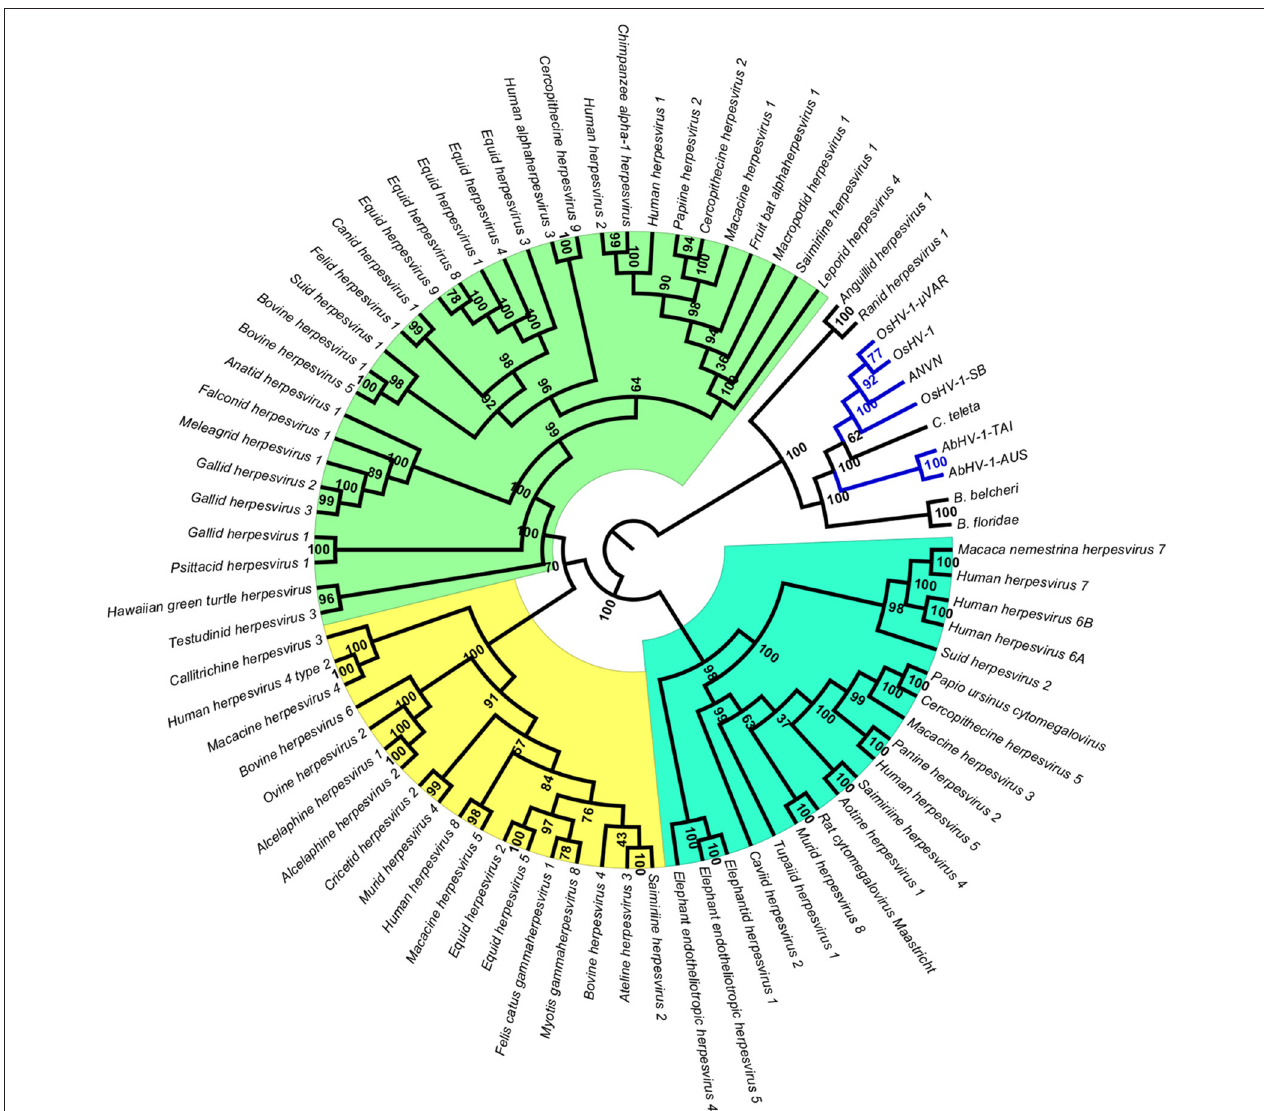
FIGURE 2 | Phylogenetic tree of catalytic subunit of DNA polymerase . The blue lines represent Malacoherpesviridae hits. Background colors highlight alpha-Herpesvirales in green, beta-Herpesvirales in blue, and gamma-Herpesvirales in yellow. The circular cladogram was computed with the Neighbor Joining algorithm and Jukes-Cantor distance estimation. Bootstrap values are reported for each node as percentages calculated over 1,000 performed replicates, with a significance cutoff set at